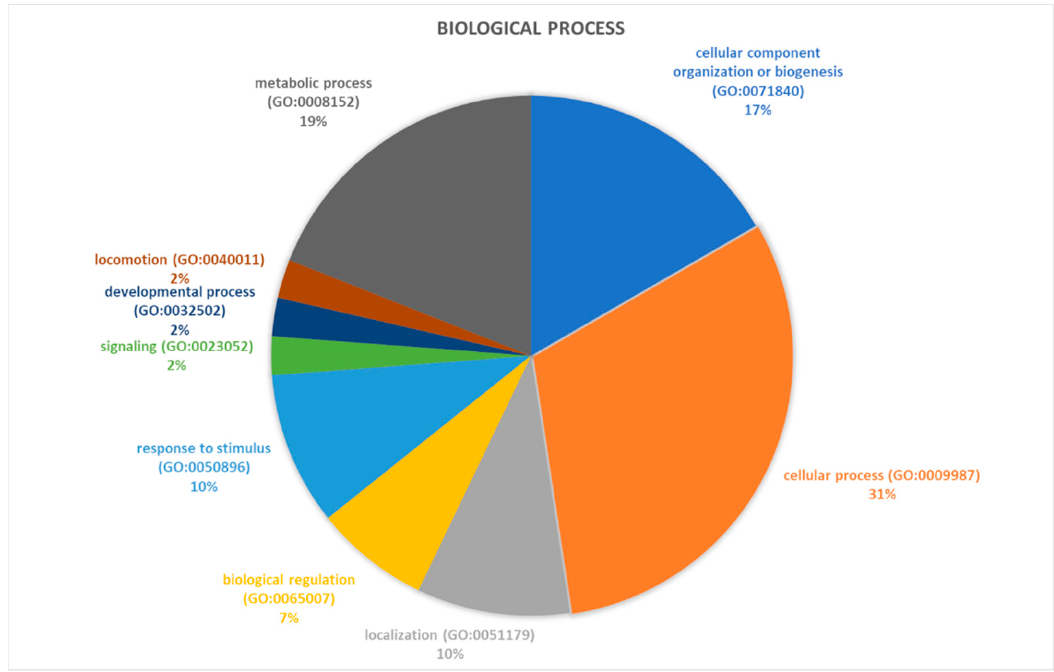
Figure 2. PANTHER classification of differently regulated proteins in RAOM in according to their biological processes. Int. J. Mol. Sci. 2020 , 21 , x FOR PEER REVIEW